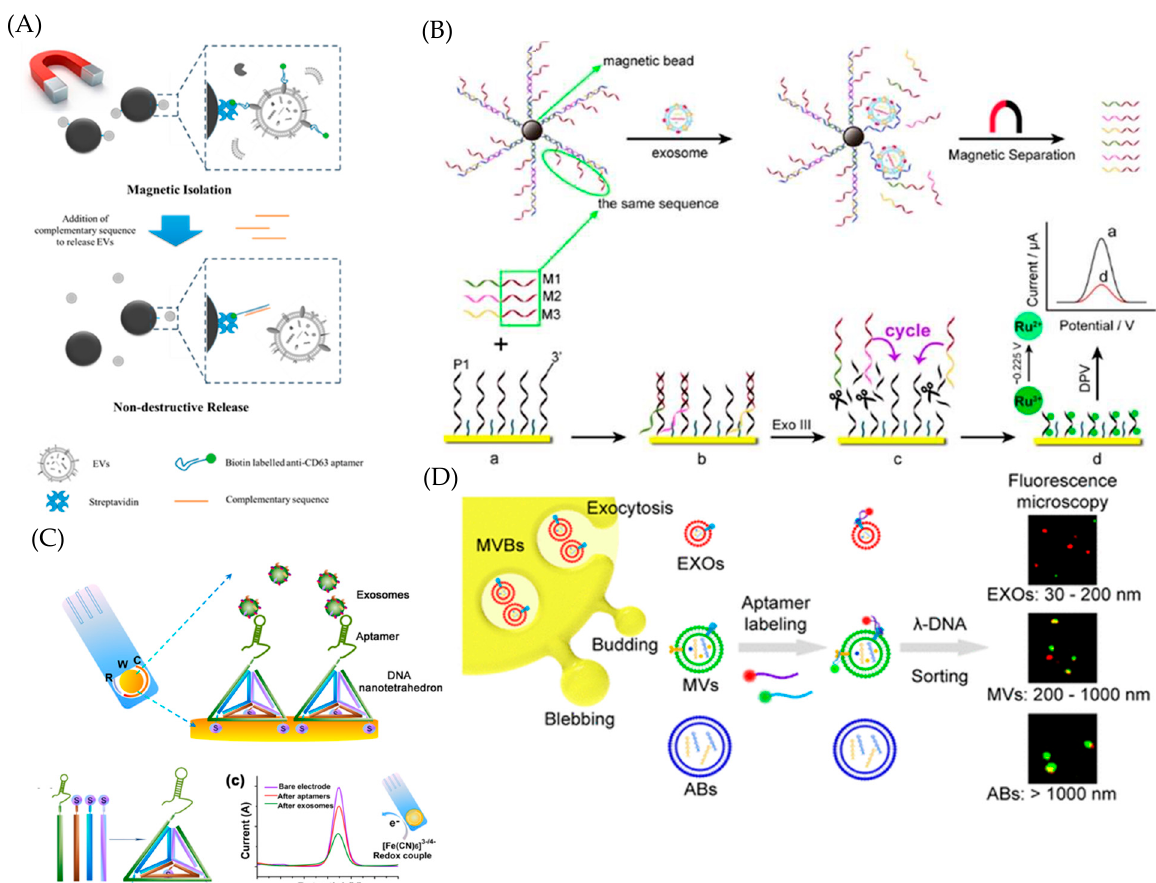
Figure 4. Schematic illustration of aptamer ‐ based techniques for the capture and detection of EVs. ( A ) DNA aptamer ‐ based magnetic isolation system (AMI) for the rapid capture and nondestructive release of EVs. Reprinted with permission from ref. [97]. ( B ) Electrochemical detection of tumor exosomes based on aptamer recognition ‐ induced multi ‐ DNA release. Reprinted with permission from ref. [153]. ( C ) Nanotetrahedron ‐ assisted aptasensor for the electrochemical detection of cancerous exosomes. Reproduced with permission from ref. [92]. ( D ) λ‐ DNA ‐ mediated sorting of EV subpopulations and aptamer ‐ mediated fluorescence analysis of EVs. Reproduced with permission from ref. [91] .